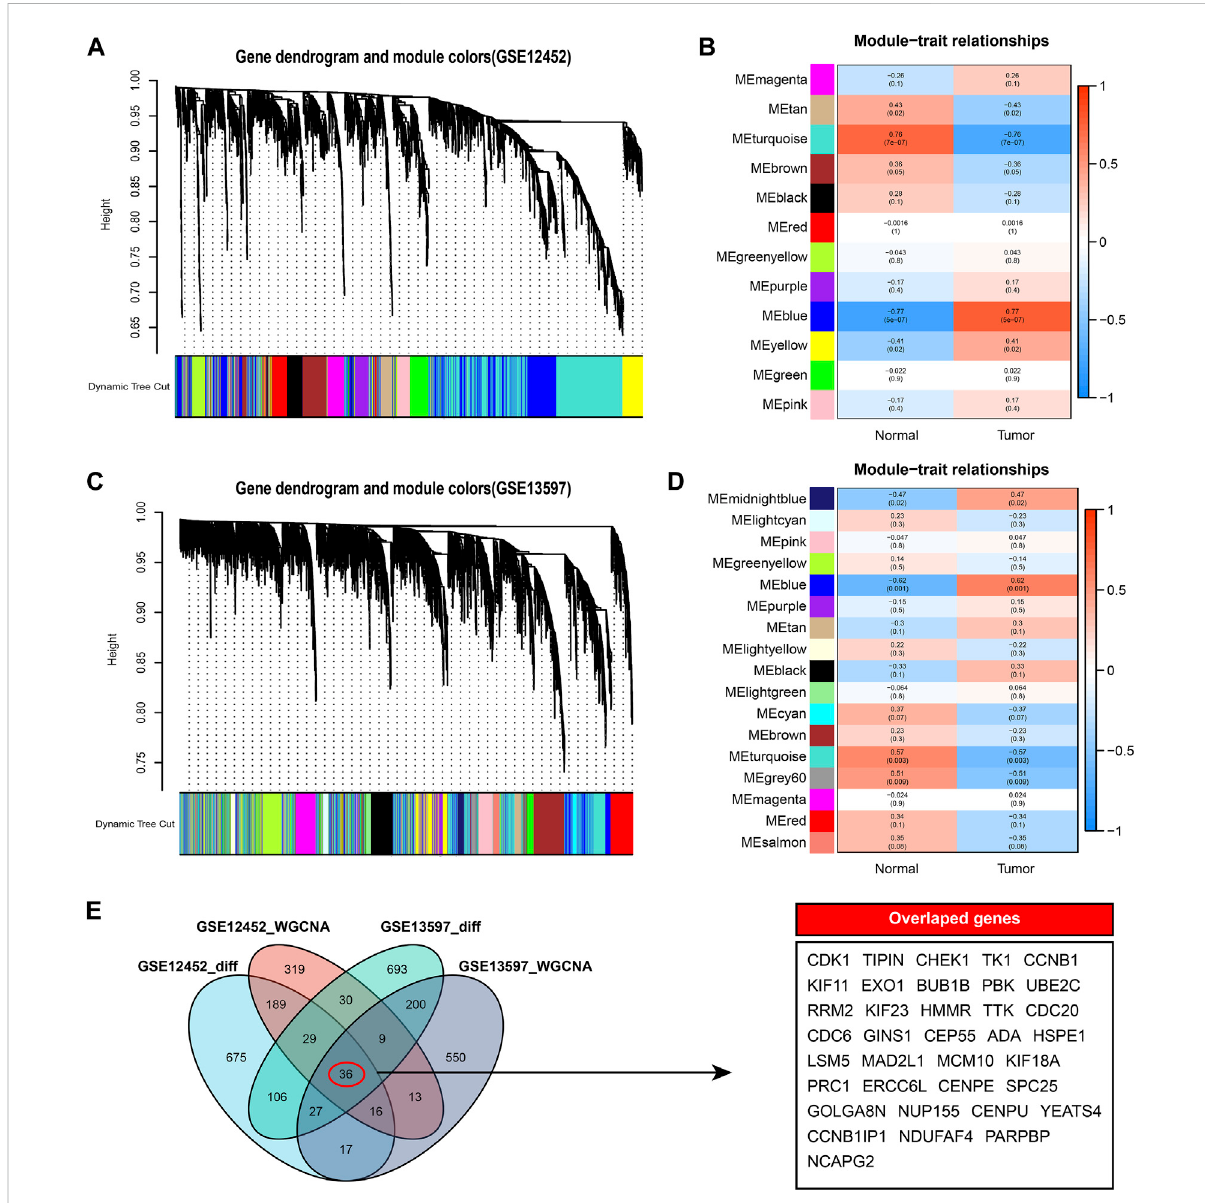
FIGURE 4 WGCNA co-expression network analysis. (A – B) . WGCNA analysis of tumor samples in the GSE12452 data set. A total of 12 signi fi cantly correlated moduleswereobtained, amongwhichMEblueshowed thestrongestcorrelation with highexpressionof AURKA ; (C – D) . WGCNA analysis oftumorsamplesintheGSE13597dataset.Atotalof17signi fi cantly correlatedmoduleswereobtained,amongwhichMEblueshowedthestrongest correlation with high expression of AURKA ; (E) . Venn diagram results of genes and differential genes of the most signi fi cant related modules in WGCNA. A total of 36 hub genes were identi fi ed. WGCNA, Weighted Gene Co-Expression Network Analysis; TOM, Topological overlap matrix; ME, Module eigengene; AURKA , Aurora kinase